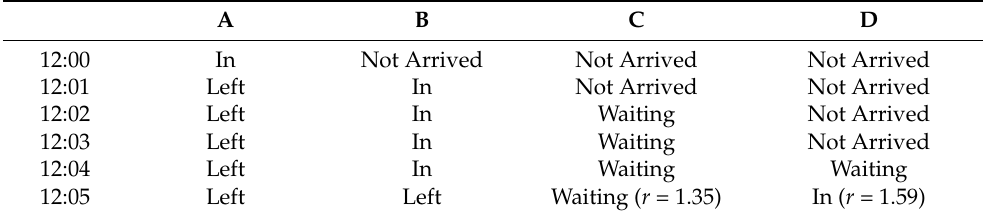
Table 3. Process of the example in Table